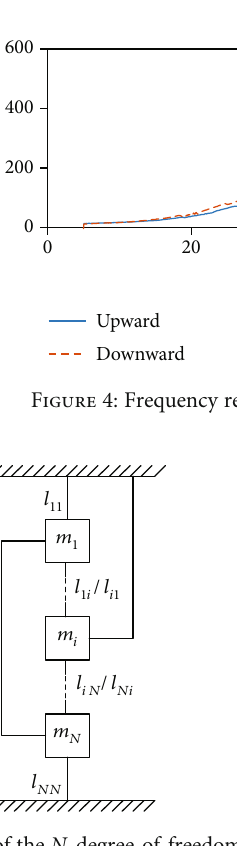
Figure 3: Frequency response characteristics of the folding fi n without freeplay.